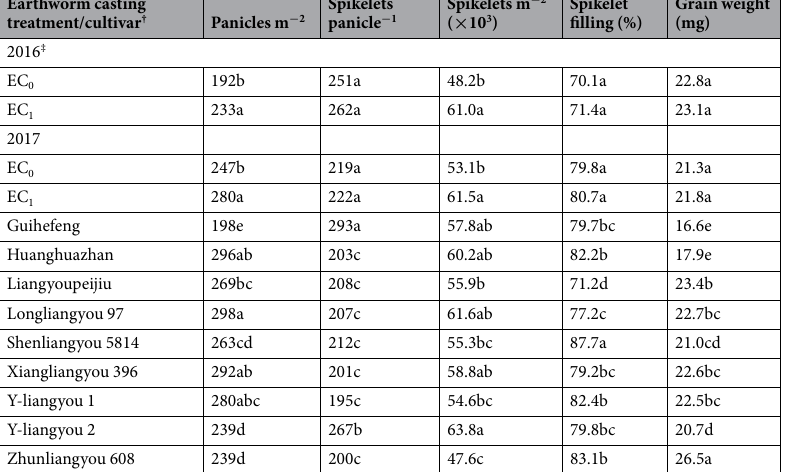
(Table 2). There was no significant difference in spikelets panicle − 1 between EC 1 and EC 0 in either 2016 and 2017. EC 1 had higher spikelets m − 2 than EC 0, by 27% in 2016 and by 16% in 2017. The differences in spikelet filling percentage and in grain weight were insignificant between EC 1 and EC 0 in both years. In 2017, Longliangyou 97 had the highest panicles m − 2 , and similar values were observed in Huanghuazhan, Xiangliangyou 396 and Y-liangyou 1 (Table 2). The lowest panicles m − 2 was recorded in Guihefeng. This variety